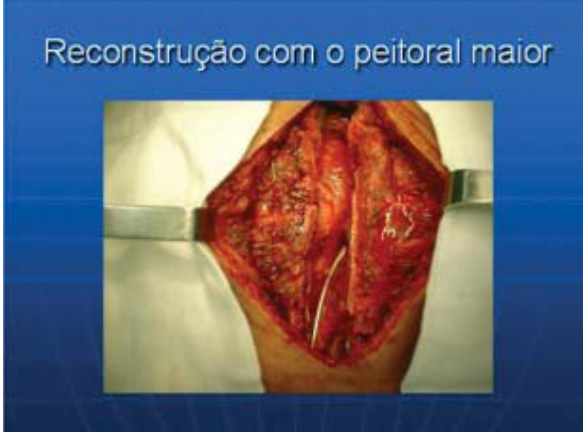
Fig. 2- Ferida esternal ,após debridamento completo e dissecção bilateral do peitoral maior com dreno no mediastino anterior